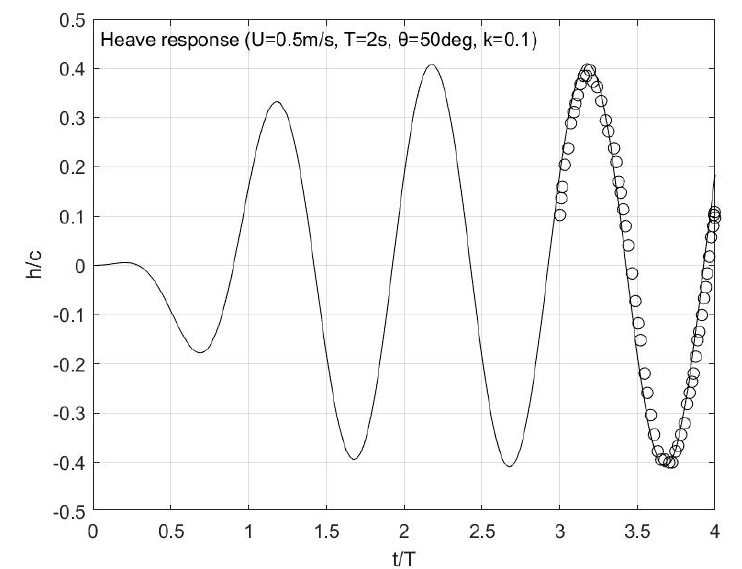
Figure 5. Dimensionless heave motion (corresponding to the amplitude of oscillatory motion of the device in the transverse direction) for the same case as in Figure 4. Experimental data from [7] are indicated by using symbols.